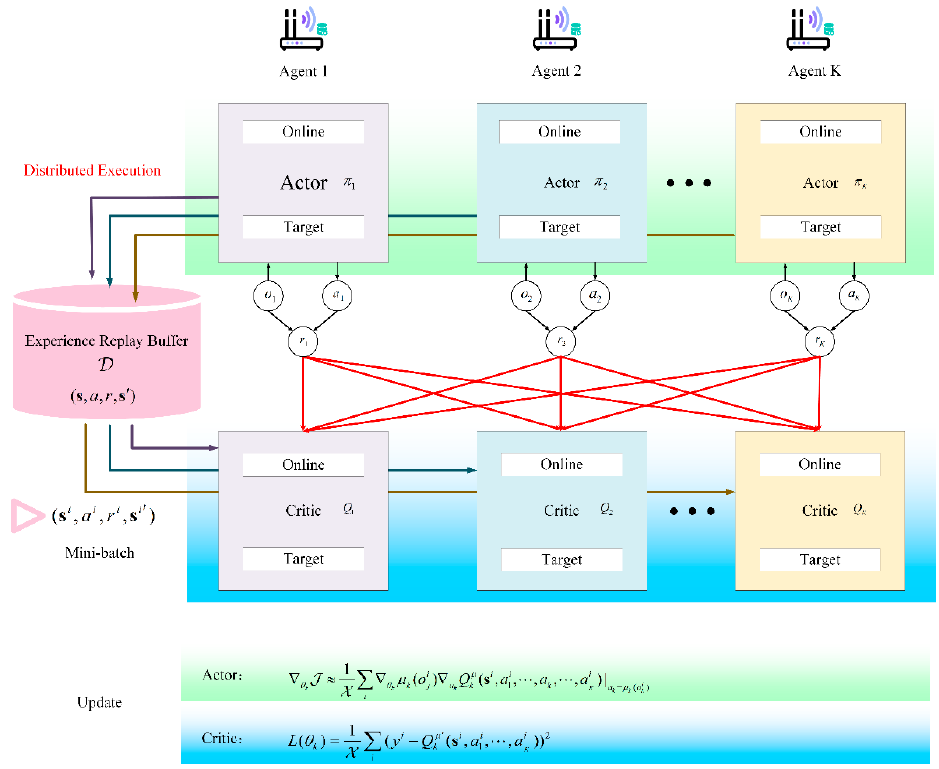
Figure 3. Multiagent deep deterministic policy gradient (MADDPG) framework.